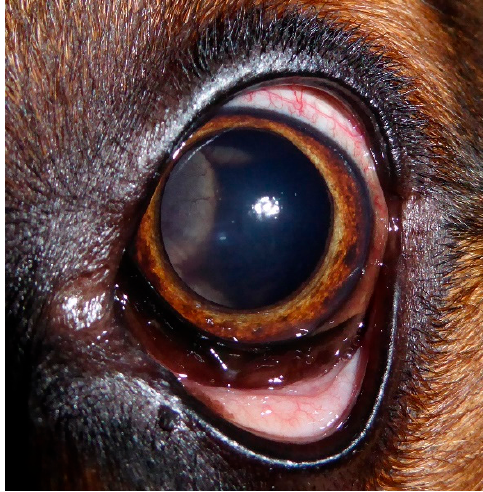
Figure 1. Left eye with mydriasis and episcleral hyperemia. The protrusion of the retina is visible. On the next day, heart rate and blood pressure largely normalized (95 bpm, 186/93 mmHg), and IOP no longer showed any remarkable difference (left 12 mmHg and right 11 mmHg). A left pupil reaction was barely noticeable. Anti-inflammatory treatment was continued, and several blood tests were